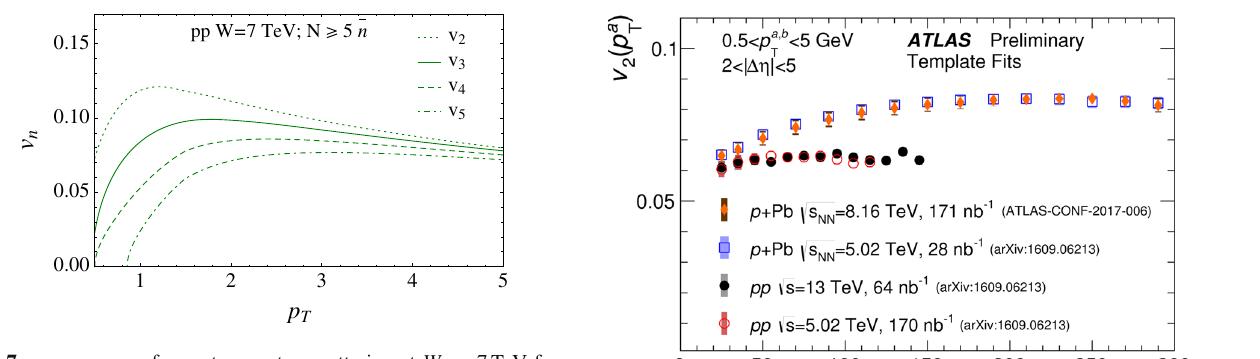
Fig. 7 v 2 versus p T for proton–proton scattering at W = 7TeV for the multiplicities N ≥ 5 ¯ n ×